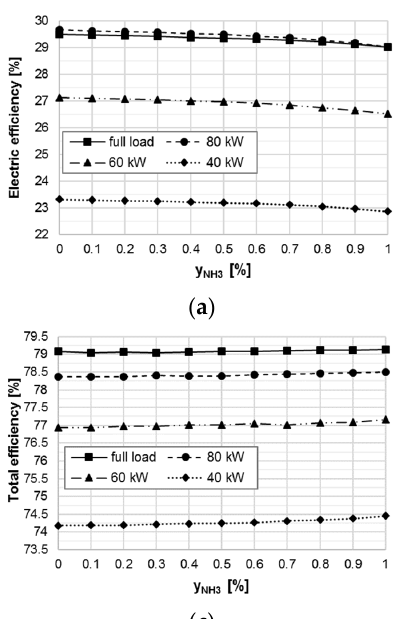
Figure 10. Effects of NH 3 feeding, at different levels of power output, on: ( a ) electric efficiency; ( b ) thermal efficiency; ( c ) total efficiency; ( d ) CO 2 emission intensity.